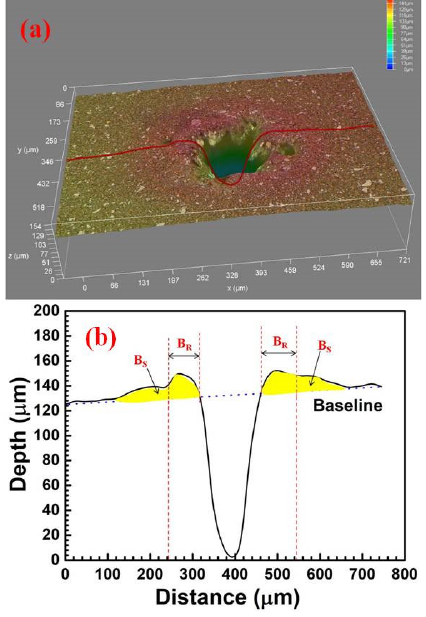
Figure 3. The geometry of the micro-orifice after 500 h of immersion at 290 °C. ( a ) The three-dimensional shape of the micro-orifice. ( b ) The depth profile of the line shown in ( a ).